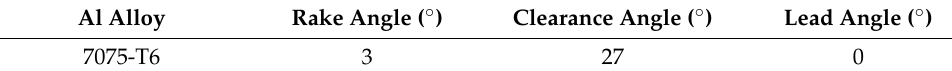
Figure 6. Cutting insert showing rake angle.